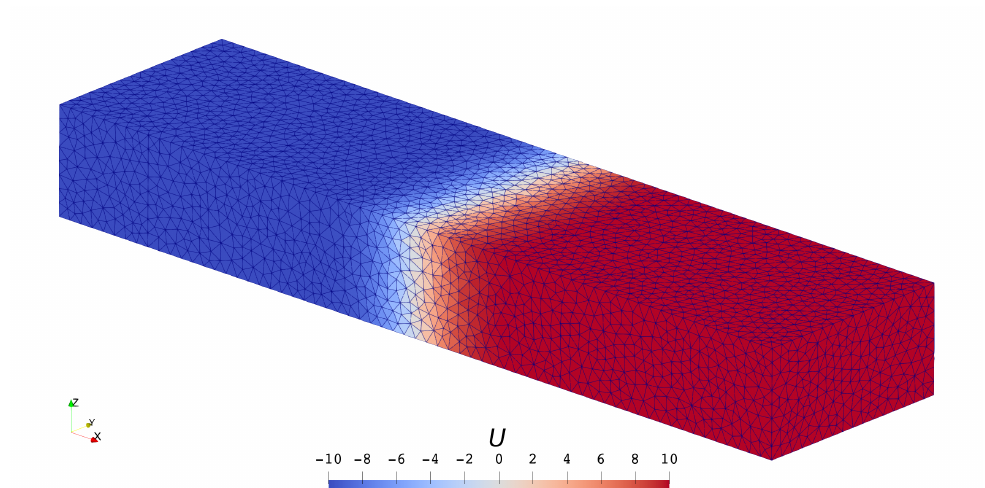
Figure 2. First-order solution of Problem 1 on small ( h ≈ 2 − 4 ) cells.